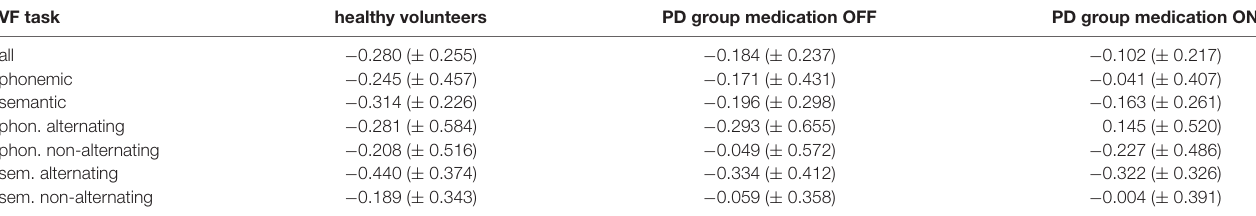
TABLE 3 | Word frequency change across VF task